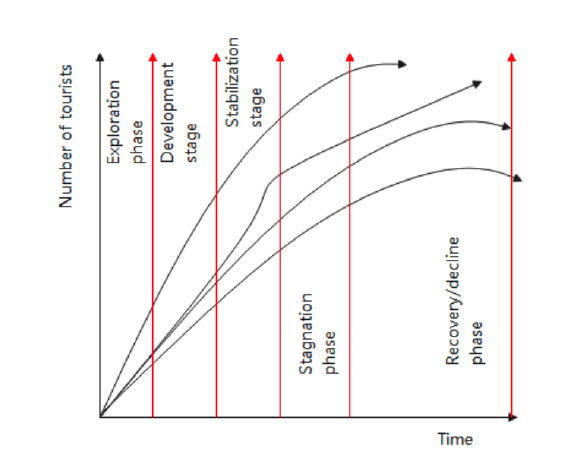
Fig. 2. Life cycle model of tourist